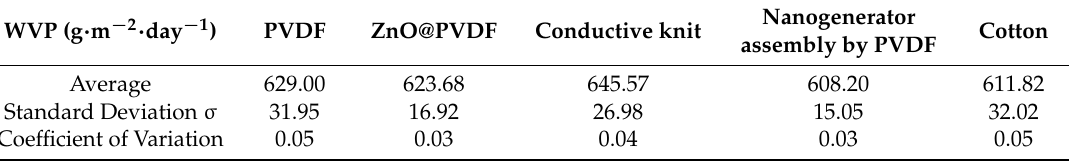
Table 3. Water vapor permeability (WVP) for various membranes and fabrics.